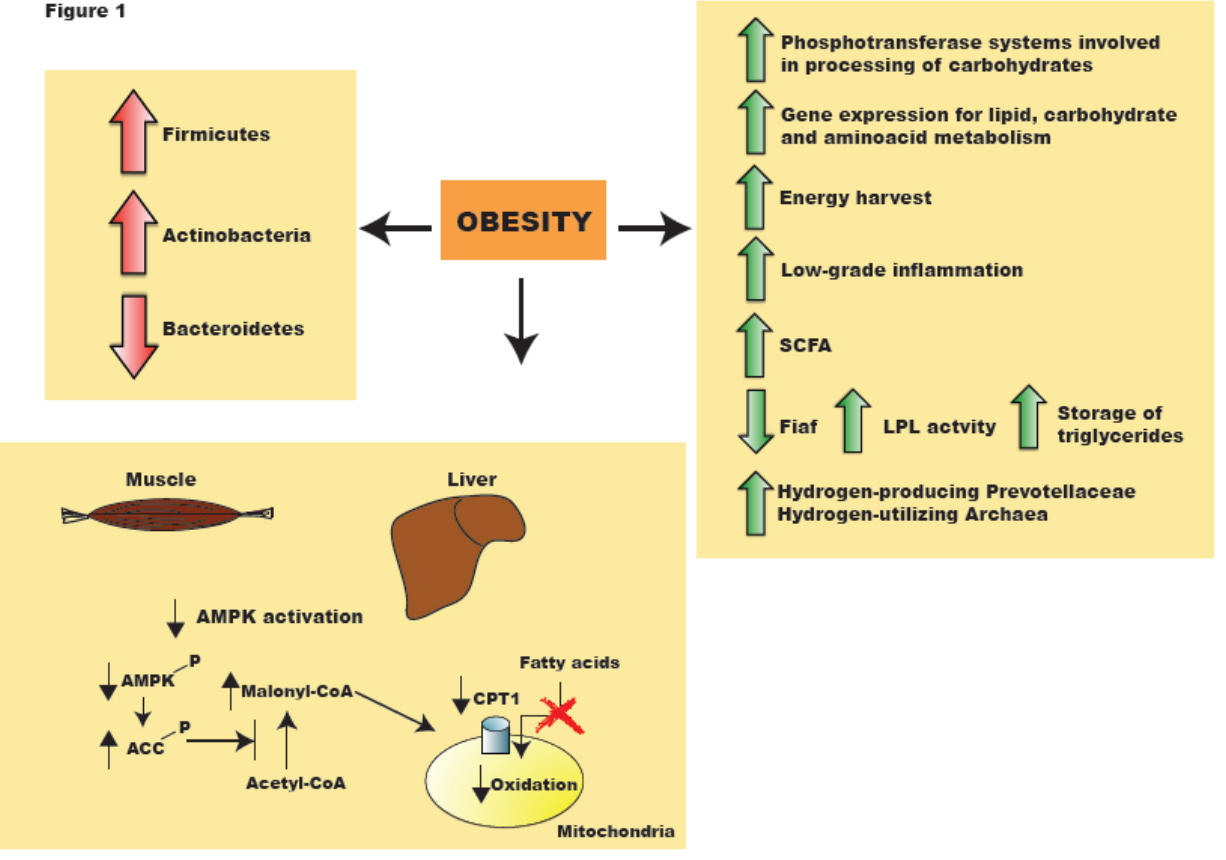
state and energy harvest. AMPK: AMP-activated kinase; SCFA: short-chain fatty acids; LPL: lipoprotein lipase; ACC: acetyl-CoA carboxylase; CPT1: carnitine palmitoyltransferase